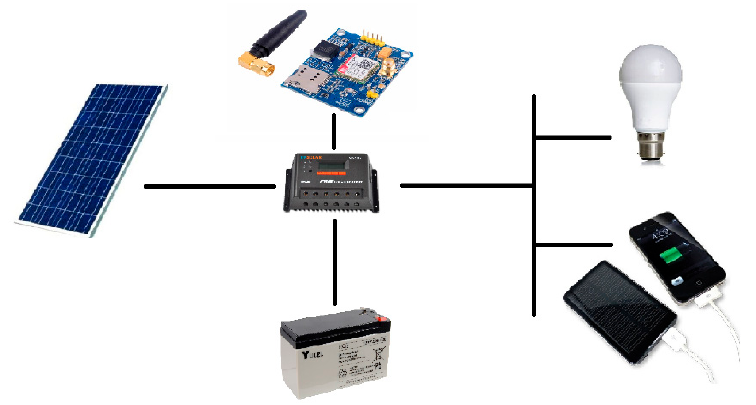
Figure 1. Typical architecture of a solar home system (SHS).